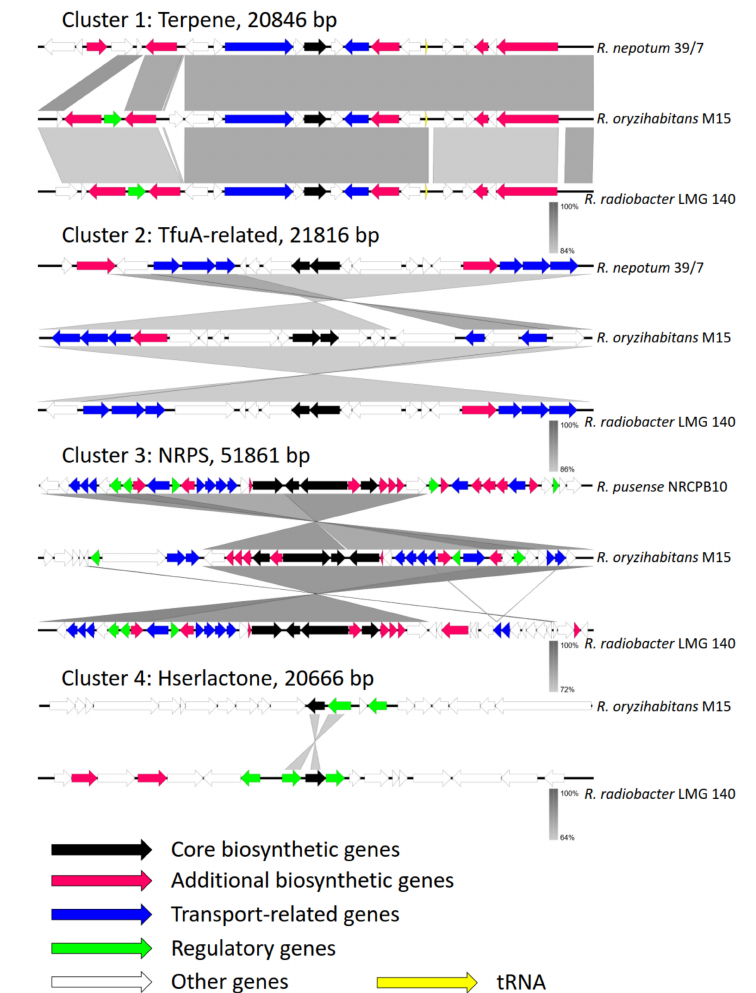
Figure 4. Comparison of biosynthetic gene clusters between strain M15 T and other closely related type species of the genus Rhizobium . Regions of conserved synteny were marked with grey ( + ) and green ( − ) shadow. Di ff erent genes are shown by di ff erent color arrows, and genes with the same color are homologous to each